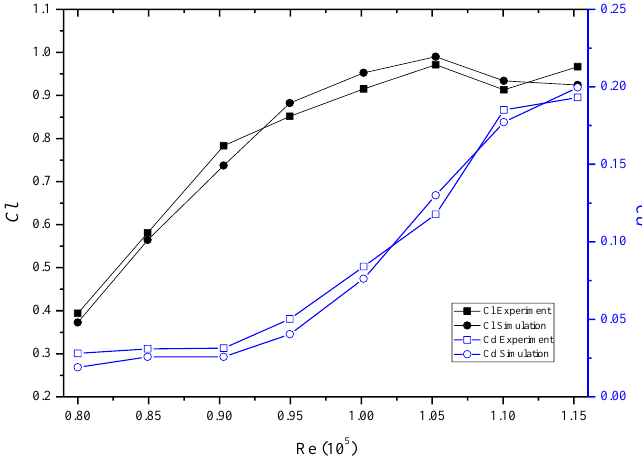
Figure 16. Comparison of experiment and simulation.